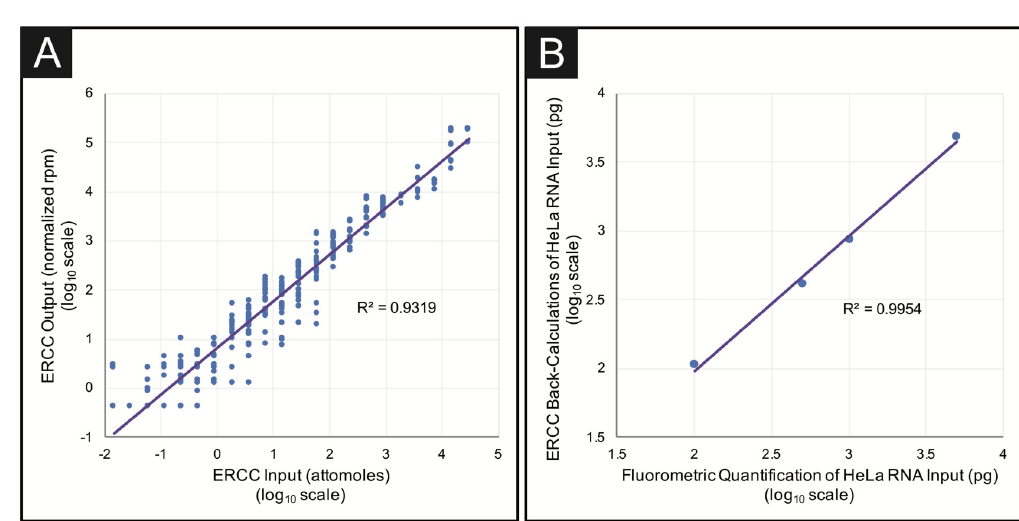
Fig 4. ERCC reads to determine library preparation quality and back-calculate RNA input mass. (A) After normalizing to RNA input mass, reads aligning to the 92 ERCC spike-in transcripts correlate linearly with ERCC spike-in concentration across six orders of magnitude in all libraries prepared with the miniaturized protocol (R 2 = 0.9319). (B) The initial sample input mass can be calculated using the ratio of ERCC reads to total sequencing reads in each sample using the equation: ERCC mass ð pg Þ Back-calculated masses of HeLa libraries correlated strongly with QuBit quantification (R 2 = ERCC reads Total reads